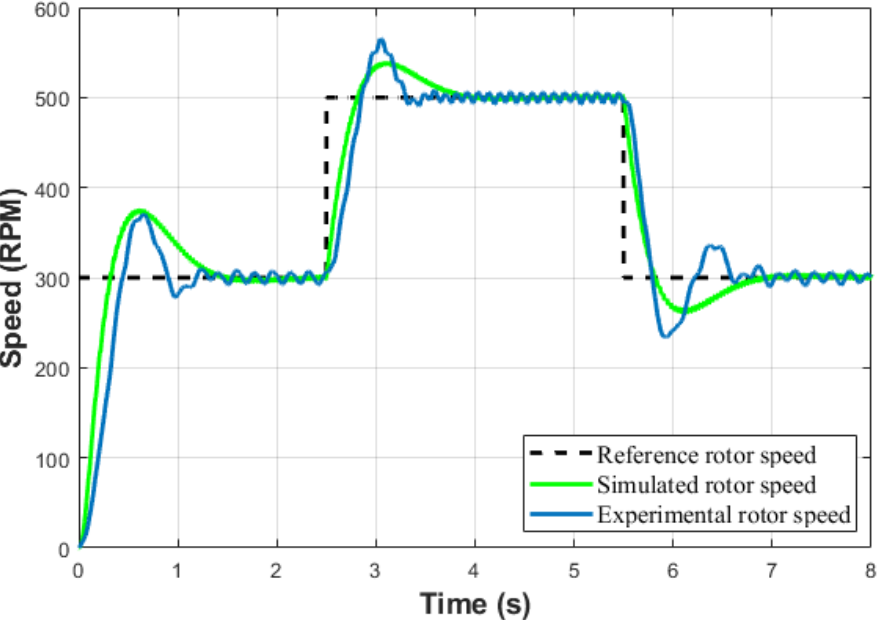
Figure 21. Behavior of the speed control loop with step